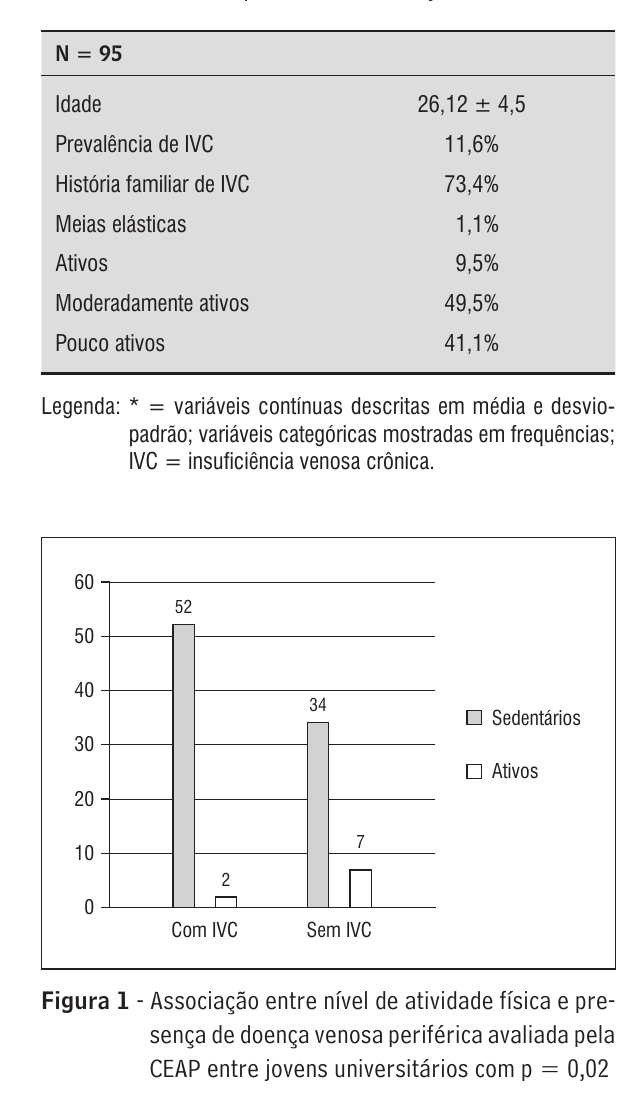
Tabela 1 - Características clínicas, prevalência de IVC de